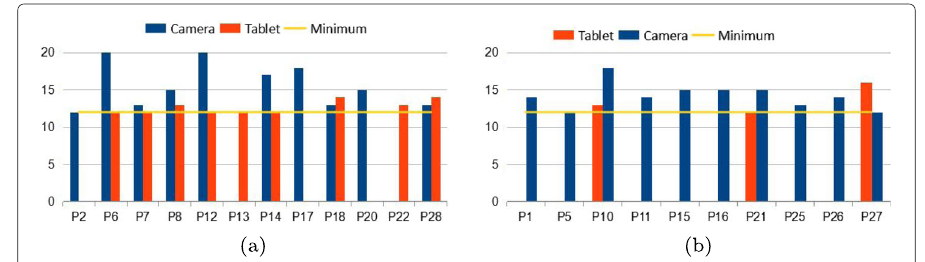
Fig. 5 Number of movements in Phase 3. a Camera - First form of interaction. b Tablet - First form of